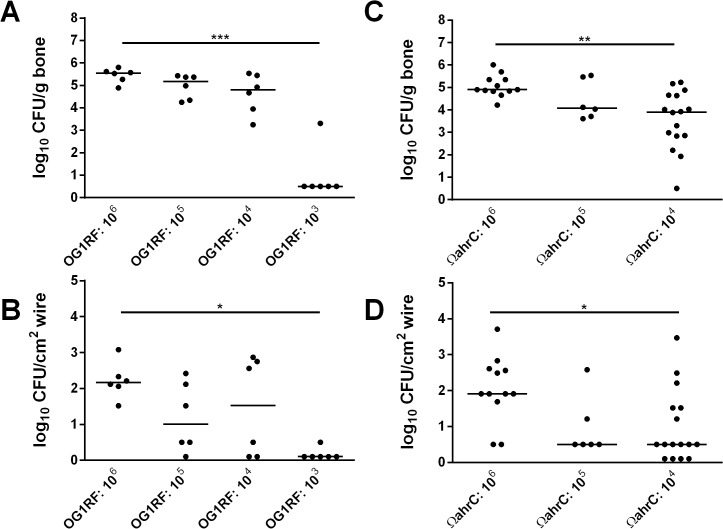
Quantitative bone (A, C) and wire (B, D) culture results from rats infected with decreasing concentrations of E. faecalis OG1RF (A, B) or the transposon disruption mutant ΩahrC (C, D).The approximate CFU/cm2 wire inoculum used for each set of infected rats is given on the x-axis as a power of 10. Bacterial quantities are given as the log10 CFU per gram of bone or cm2 of wire surface recovered from rats one week post-infection (y-axis). Horizontal lines represent median values. The Kruskal-Wallis test with Dunn’s multiple comparison post-hoc test was used to determine significance across inocula groups in each panel. ***, p-value < 0.001; **, p-value < 0.01; *, p-value < 0.05.